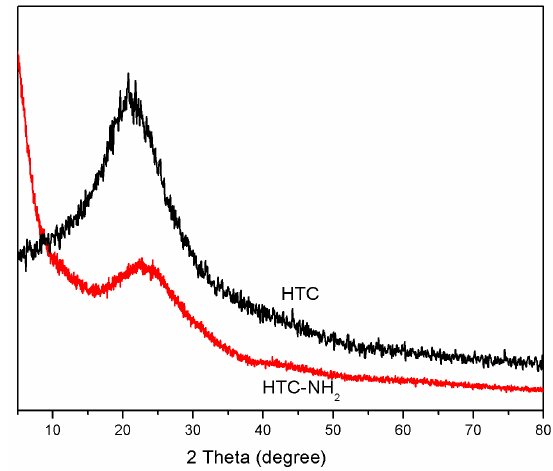
Figure 3. X-ray diffraction (XRD) curves of HTC and HTC-NH 2 .